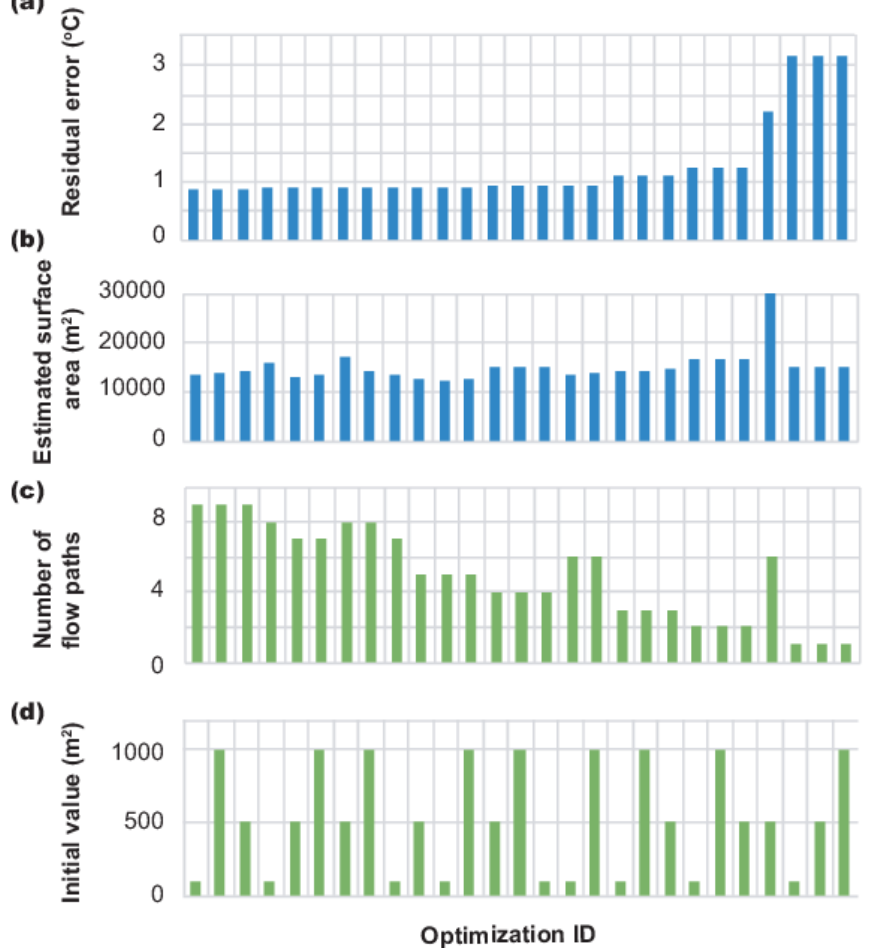
Figure 14. Optimization of surface area between well B4 and B9 in Balcova geothermal field. ( a ) residual errors between field data and calculated curve, ( b ) estimated surface area, ( c ) number of flow paths, and ( d ) initial value for optimization. The optimization ID was arranged in order from the smallest residual errors.